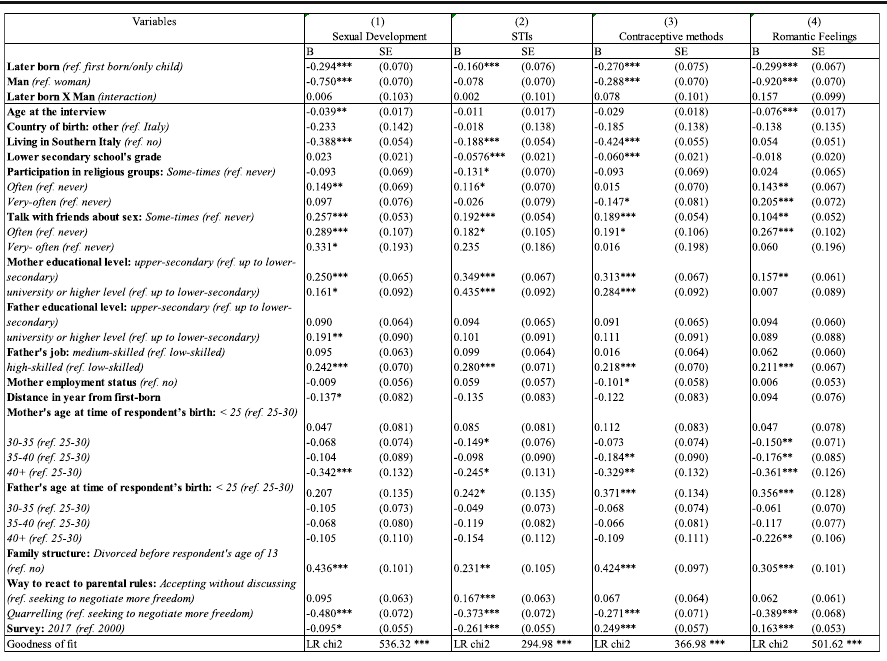
Table 2 Estimated coefficients of logistic regression models for the probability to have a deep communication with parents on sexual and romantic topics — ALL students